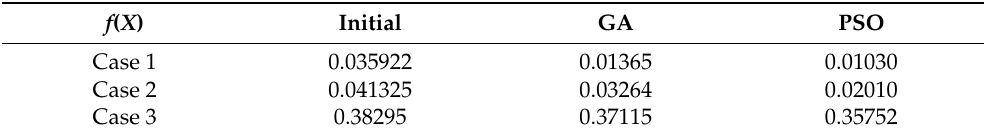
Table 4. Best objective